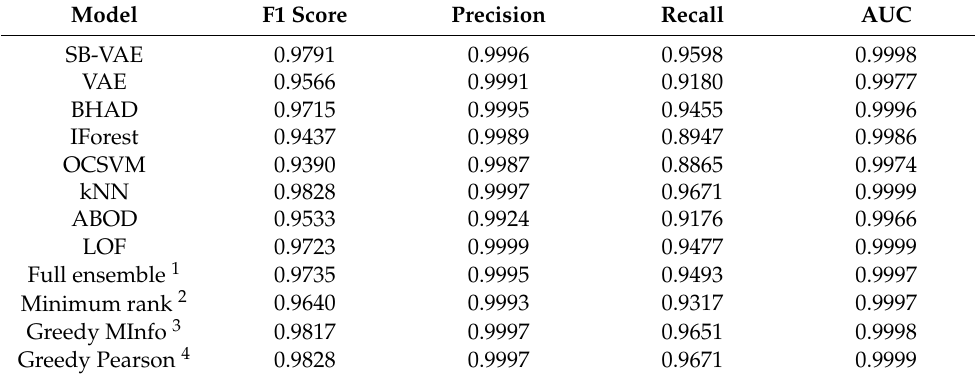
Table 1. Results—Monte Carlo